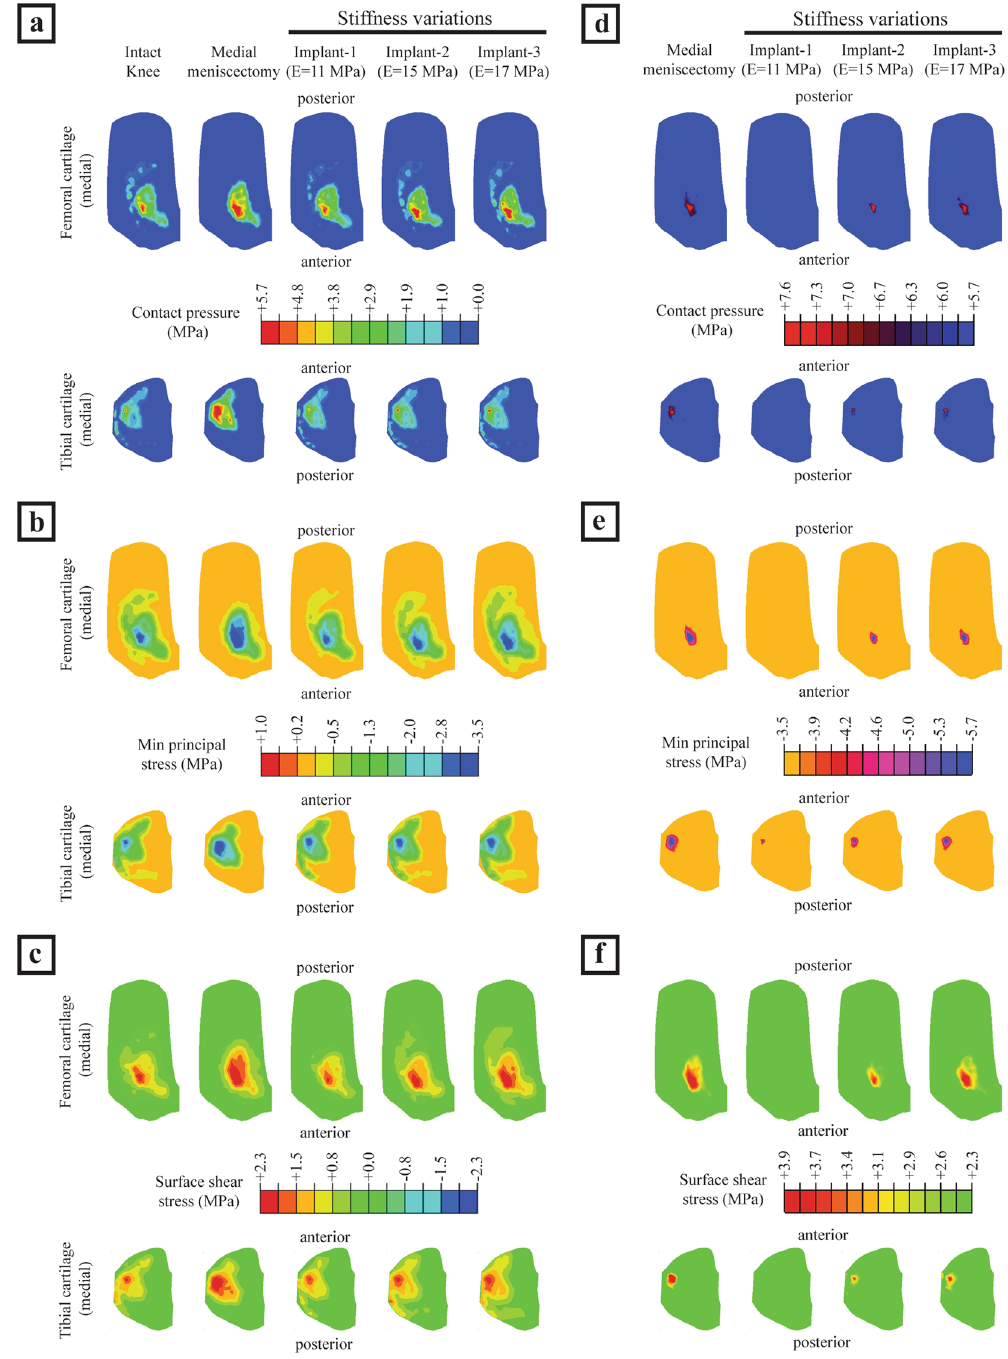
Figure 2. ( a–c ) The medial cartilage contact pressures, compression stresses (minimum principal) and shear stresses on the femoral and tibial surfaces for the intact knee, medial meniscectomized knee and the knee joint with the meniscal implant with three distinct material stiffness, and ( d–f ) femoral and tibial surfaces with contact pressures, compression stresses and shear stresses higher than the peak values of those induced by the intact